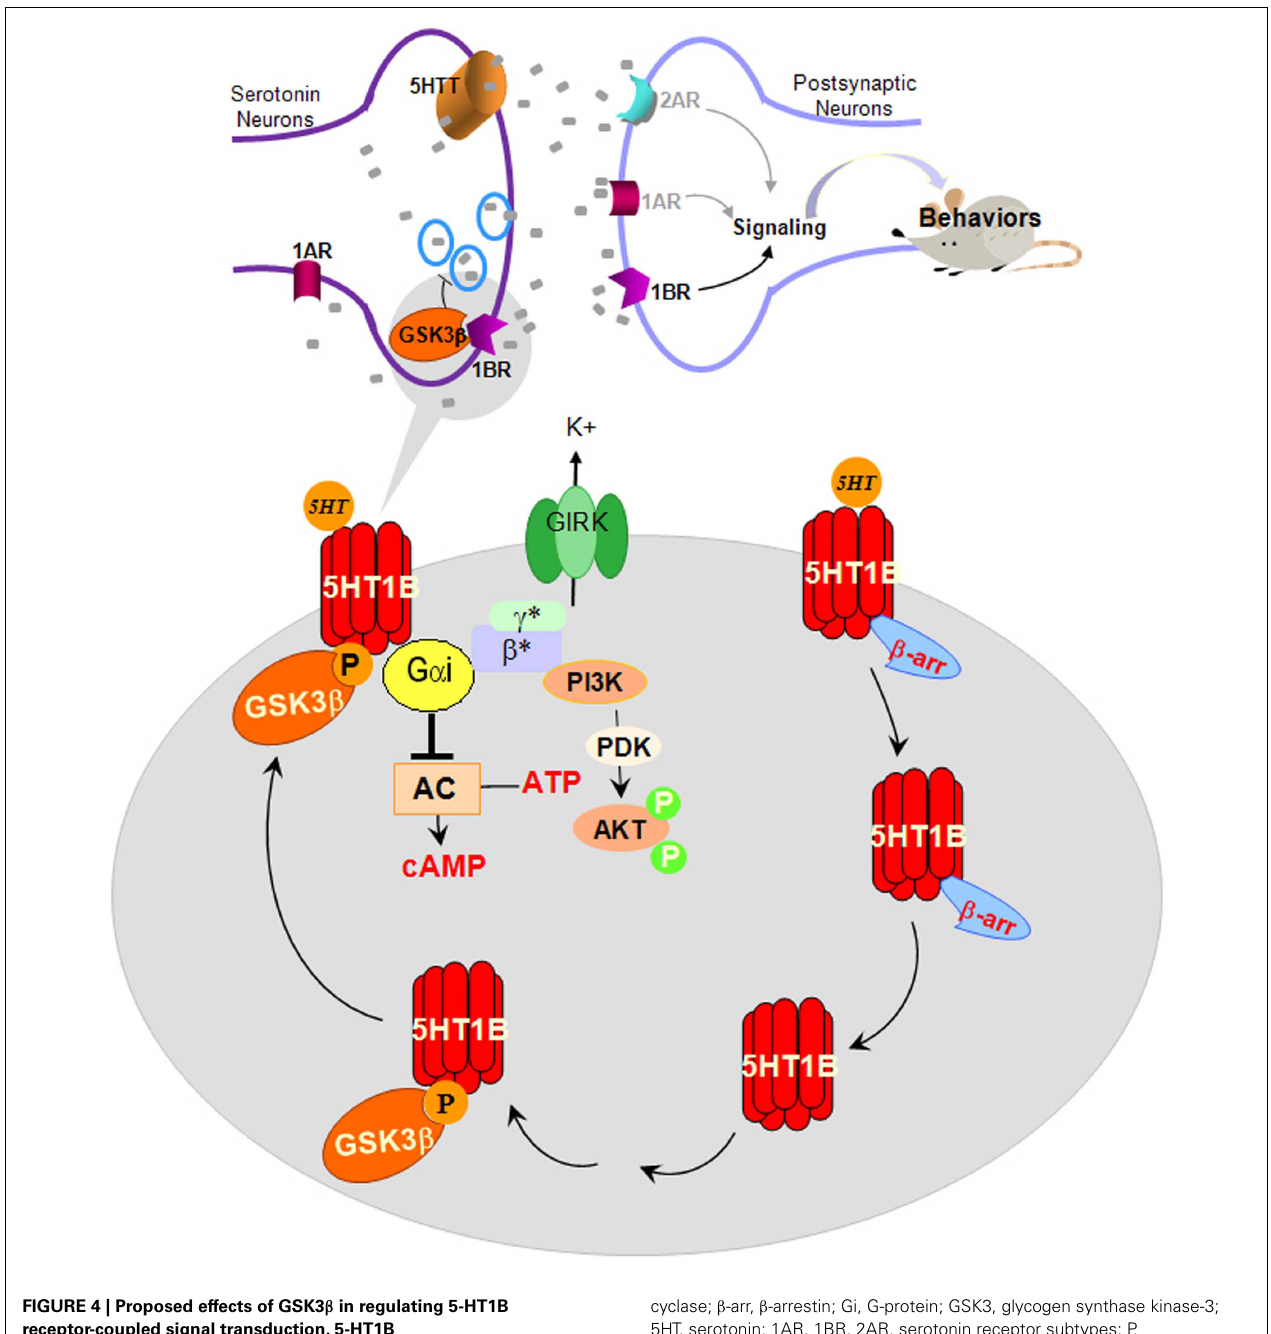
FIGURE 4 | Proposed effects of GSK3 β in regulating 5-HT1B receptor-coupled signal transduction, 5-HT1B receptor-regulated 5-HT release, and 5-HT1B receptor-regulated behaviors. α , β , γ , G-protein subunits; AC, adenylyl